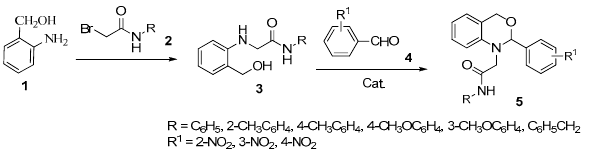
Table 1. The results of the preparation of 3,1-benzoxazines 5a a .